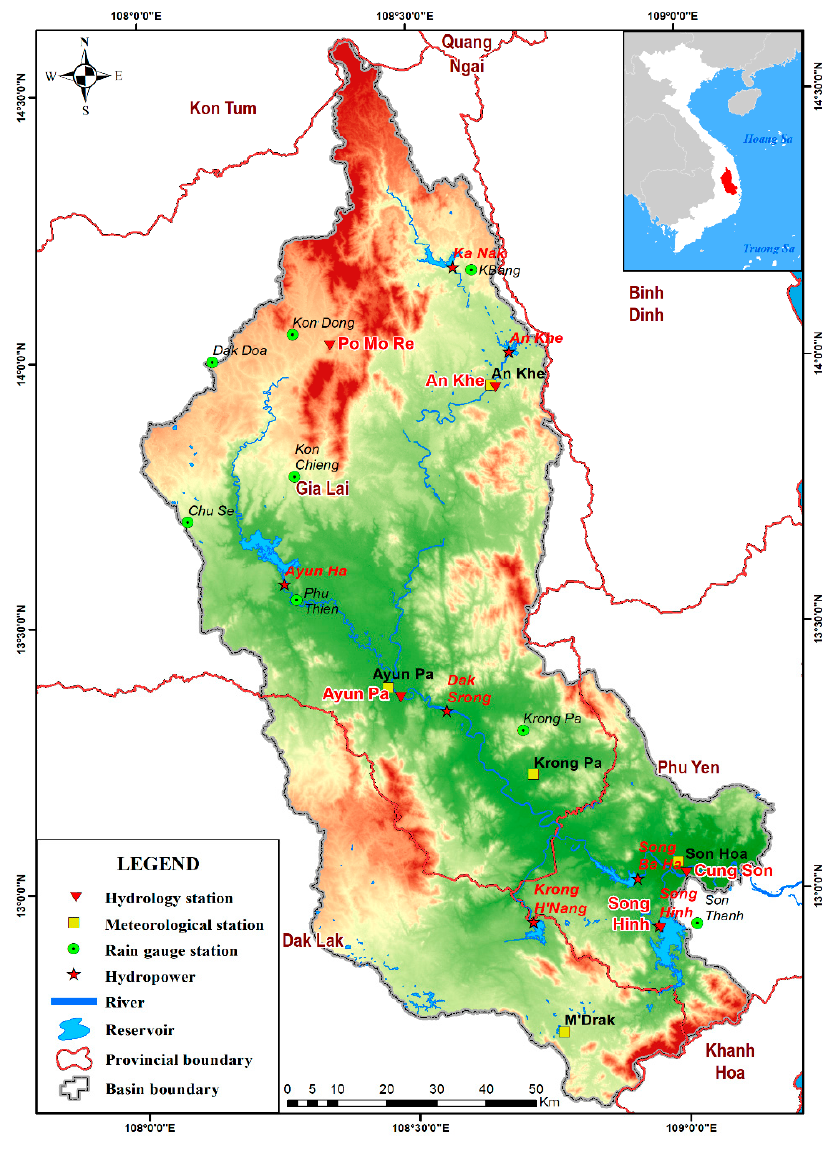
Figure 2. A map of the study site.